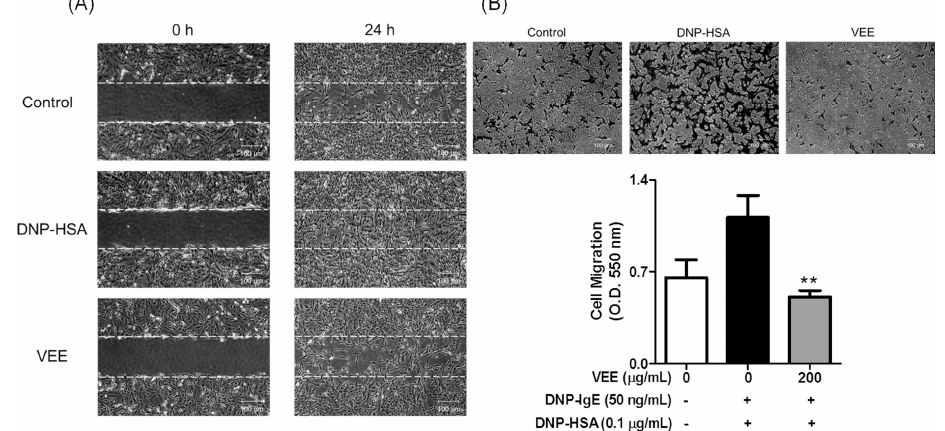
Figure 4. Inhibitory effect of VEE on cell migration of MDIM-stimulated SW1353 cells. SW1353 cells were seeded in a 60-mm dish (4 × 10 4 cells/dish) and then incubated until 95% confluence or seeding occurred on a 24-well Transwell insert (1 × 10 5 cells/well) in serum-free DMEM. The cells were then incubated with cultured media of RBL-2H3 cells for 24 h. A wound healing assay and a Transwell migration assay were performed as described in the Materials and Methods section. The data are expressed as the mean ± SD values of quadruple determinations. ** p < 0.01 versus DNP-HSA-treated group. ( A ) Wound healing assay; ( B ) Transwell migration assay.